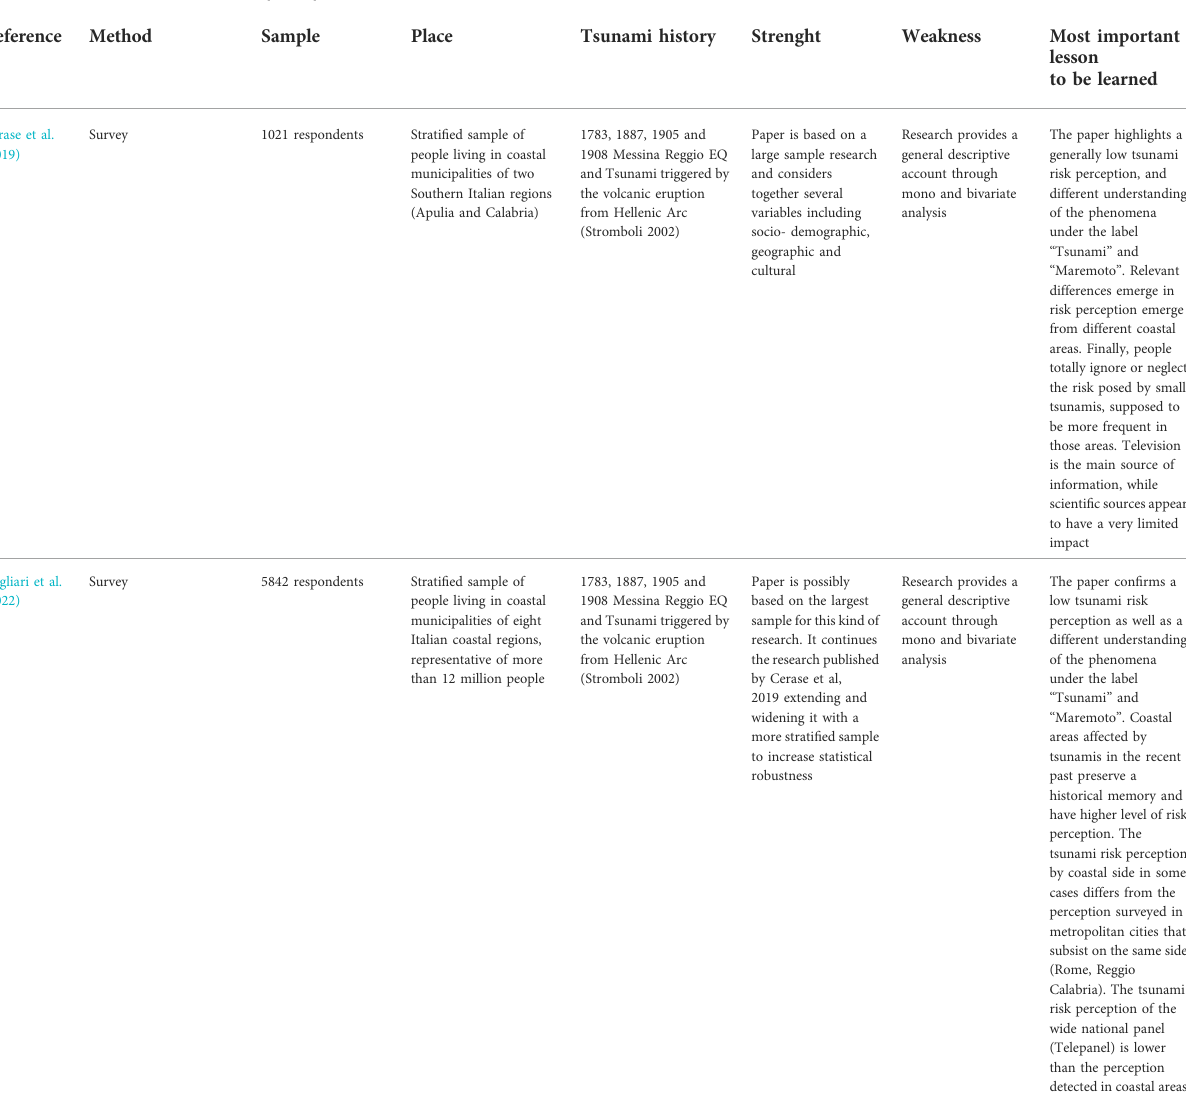
TABLE 1 ( Continued ) Tsunami risk perception research: Review